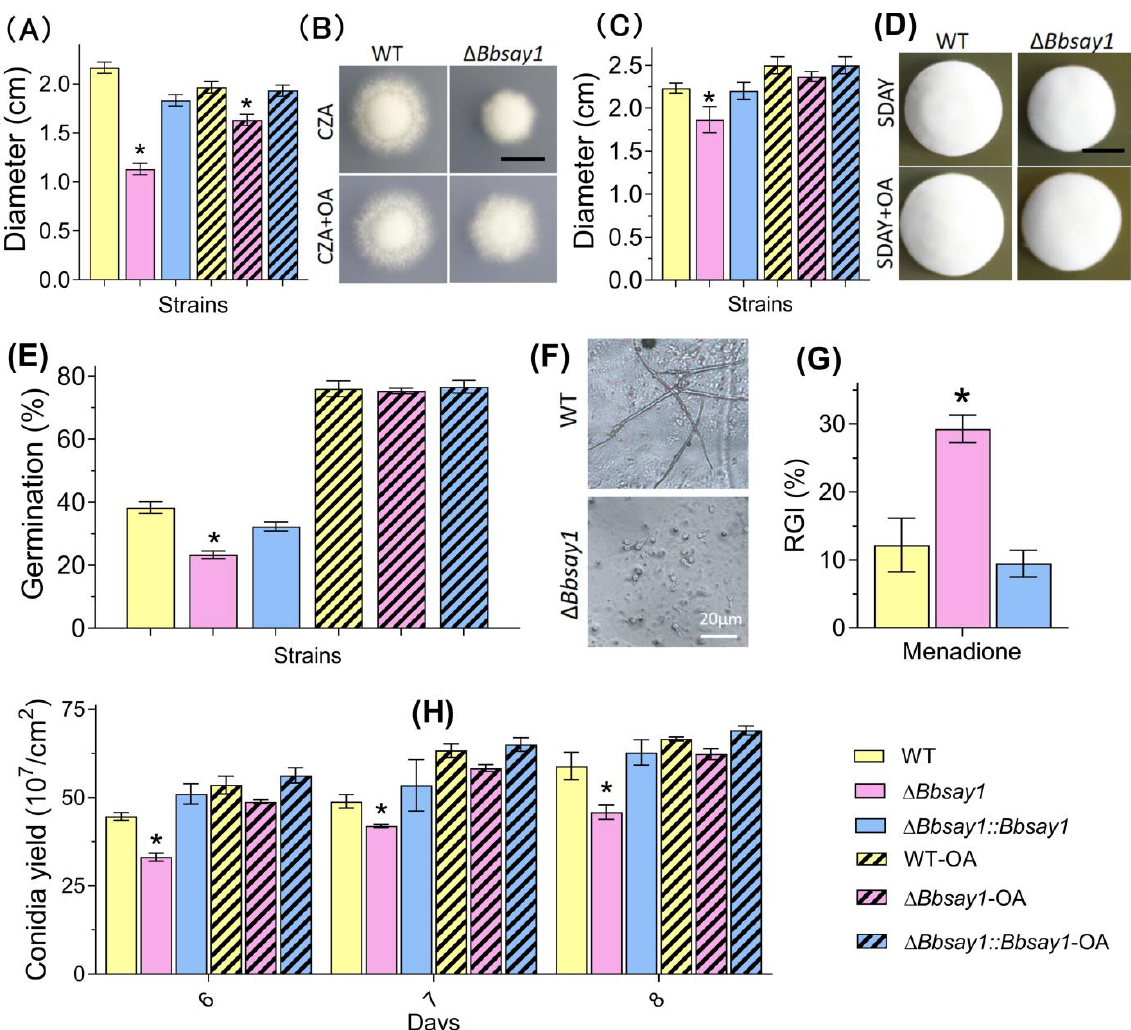
Figure 2. Fungal vegetative growth, germination, and conidiation. Fungal strains were inoculated on CZA ( A ) and SDAY ( C ) plates. After an incubation of 7 d at 25 ◦ C, the colony diameter was examined. Photographs were taken for the colonies on the CZA ( B ) and SDAY ( D ) plates. Bars: 1 cm. ( E ) Conidial germination under an oligotrophic condition. The conidia were inoculated on a water agar plate (only with agarose) and cultured for 24 h at 25 ◦ C, followed by determining the germination percentage. ( F ) Microscopic view of germlings on the hindwing of a locust. Bar: 20 µ m. ( G ) Growth under oxidative stress. The conidial suspension was inoculated on a CZA plate plus menadione and cultured at 25 ◦ C. Seven days later, the colony diameter was measured and used to calculate the relative growth inhibition (RGI). A CZA plate without manedione was used as a control. ( H ) Conidial production. Fugal strains were inoculated on SDAY plates and cultured at 25 ◦ C. The conidial yield was examined at 6, 7, and 8 d post incubation. A chemical feeding assay was conducted by adding oleic acid (OA) to the indicated medium. The asterisks on the bars indicate the significant difference in the indicated phenotype between the ∆ Bbsay1 and the wild-type (WT) or complemented strains (Tukey’s HSD: p < 0.05). Error bars: standard